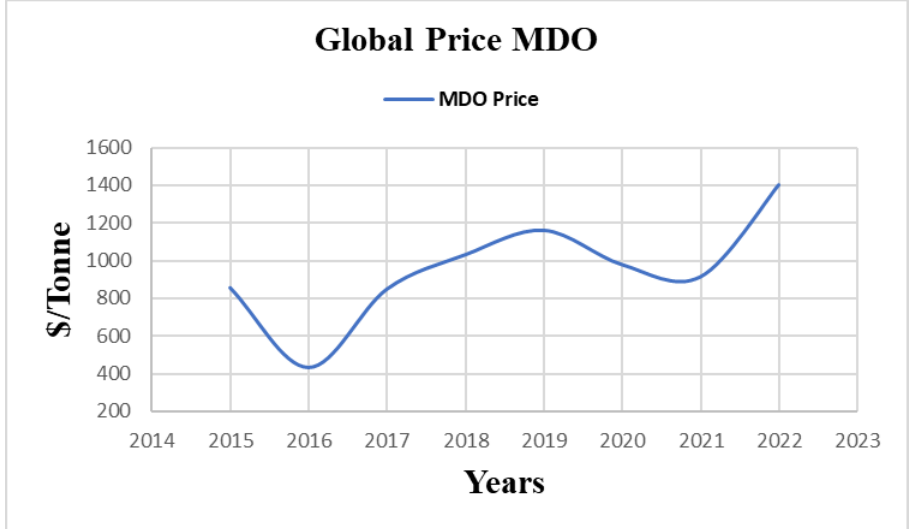
Figure 3. Global MDO fuel prices.